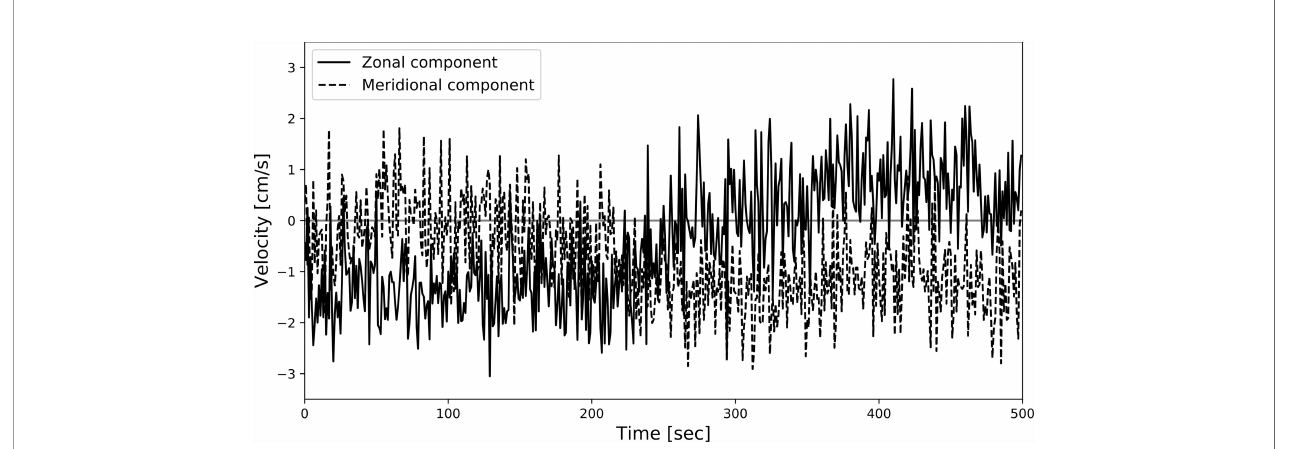
FIGURE 3 | Time series of bottom current velocity observed by the baited camera system in Fujiwara et al.